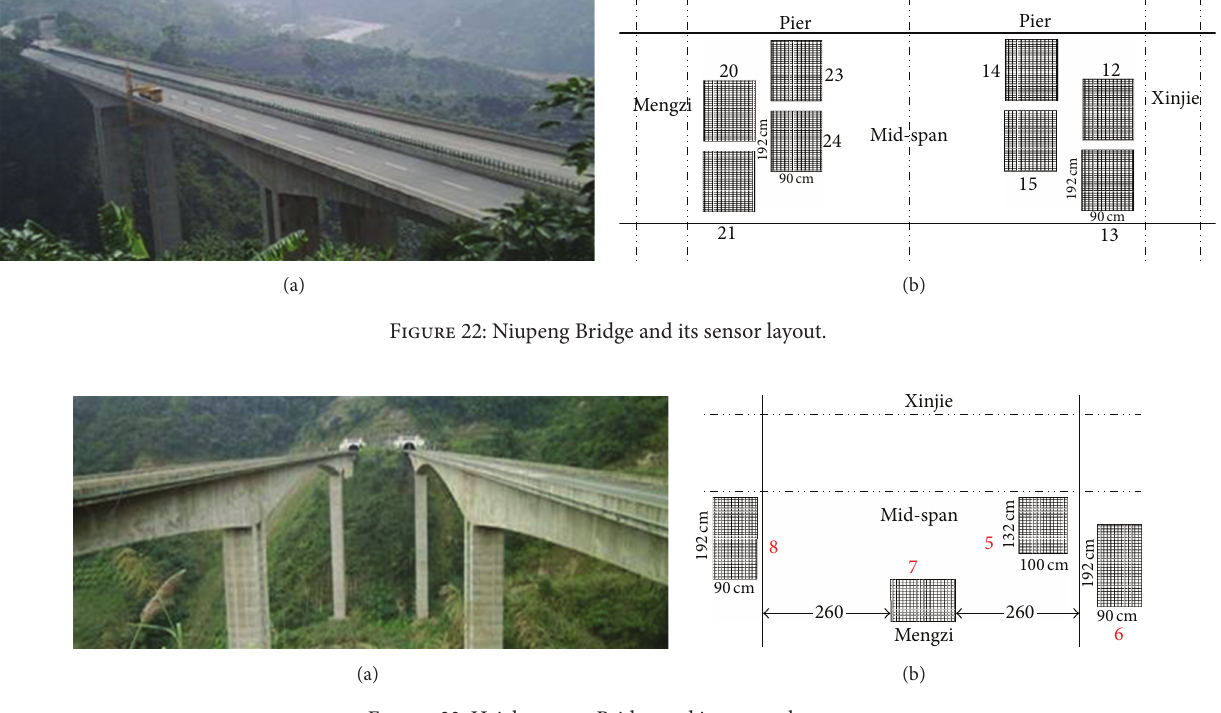
Figure 23: Heichonggou Bridge and its sensor